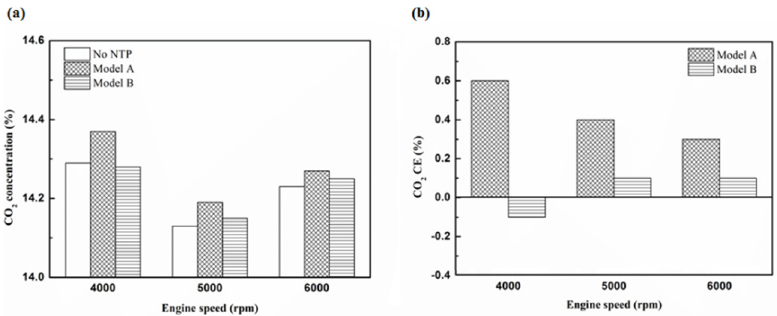
Figure 23. The CO 2 ( a ) emission values and ( b ) CE using iridium alloy in the rear of the exhaust pipe.